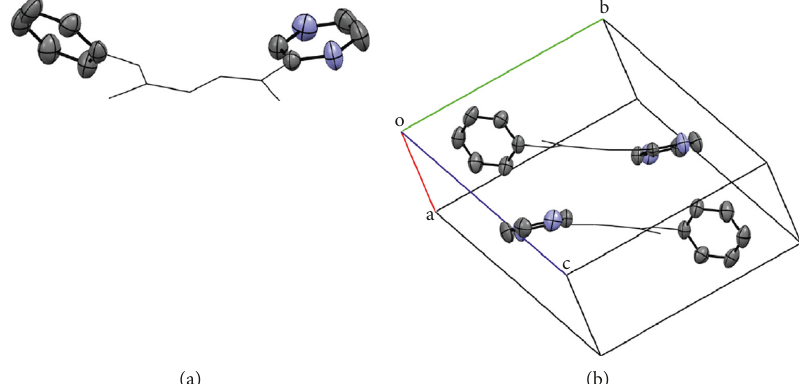
Figure 3: (a) Bent wings structure of H 2 L1 ; (b) packing of H 2 L1 (only the atoms of the aromatic rings are depicted as ellipsoids for clarity).